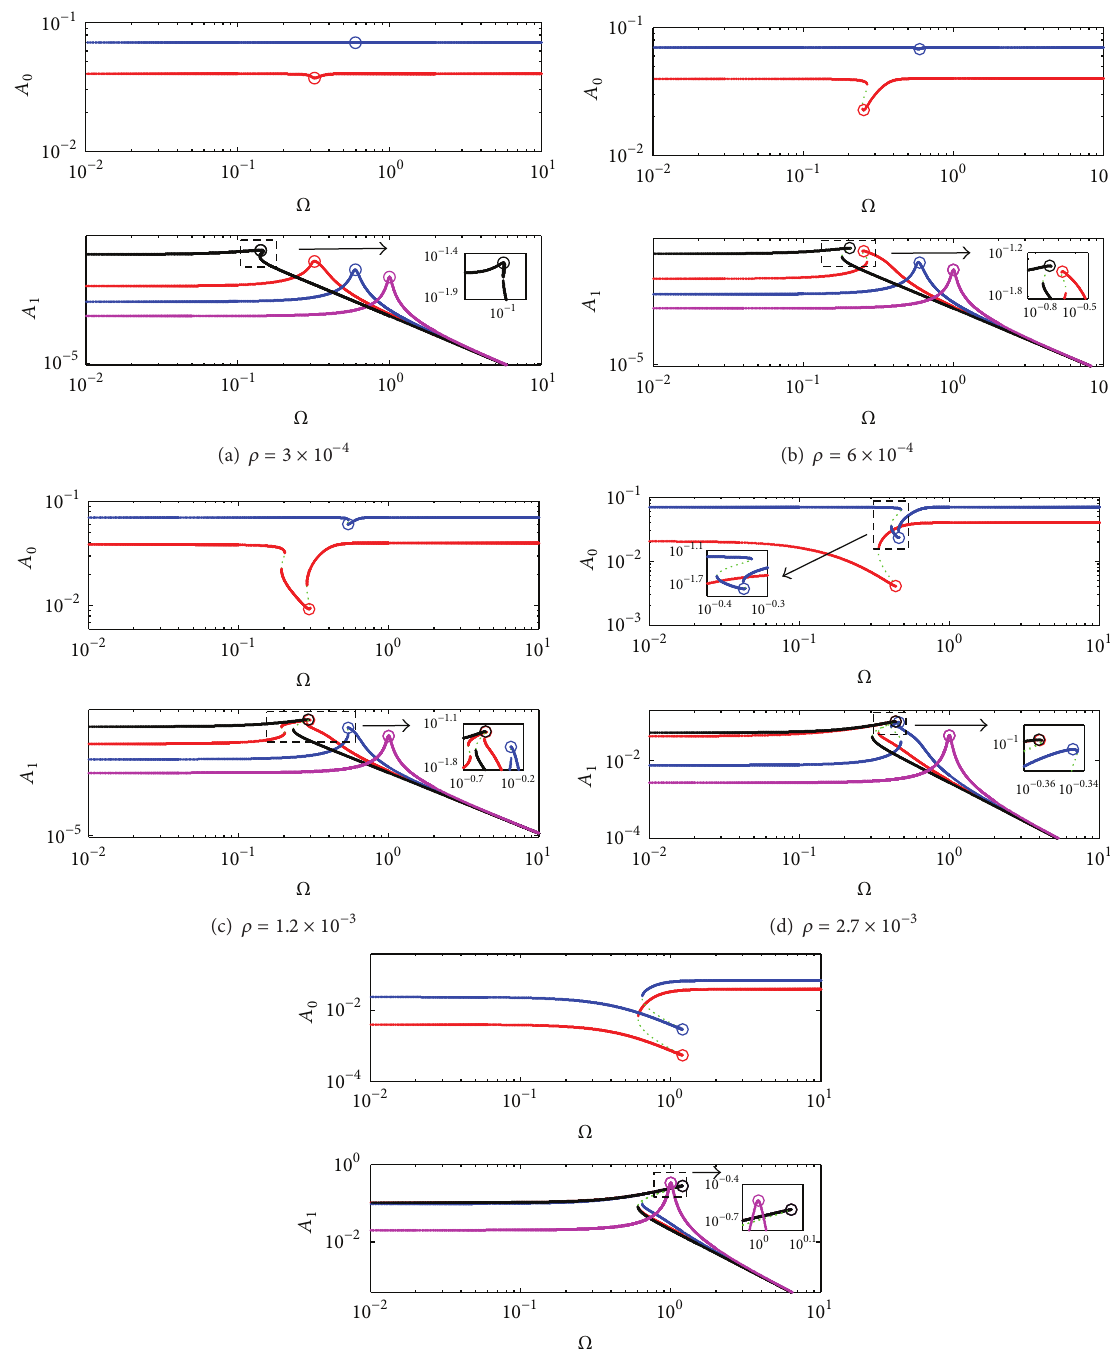
Figure 11: FRCs of the QZS isolator and ELS with different offset displacements and excitation amplitudes for the force excitation. “Red line” the disturbed isolator with ̂𝑢 0 = 0.04 ; “blue line” the disturbed isolator with ̂𝑢 0 = 0.07 ; “black line” the ideal isolator; “magenta line” ELS; “green dotted line” unstable solutions; “o” peak amplitude of